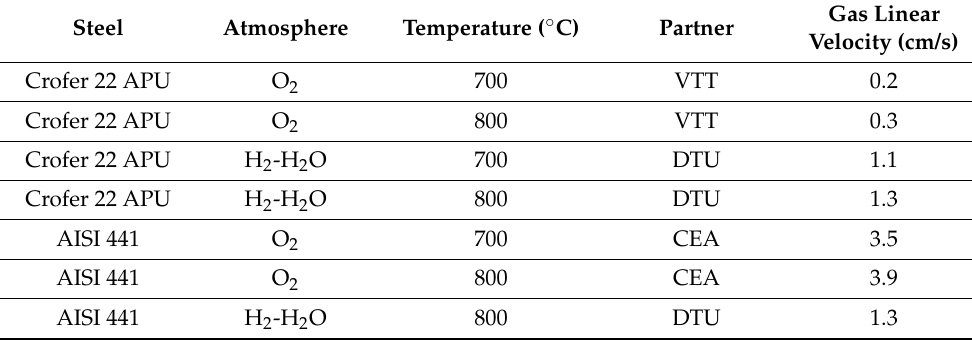
Table 3. Gas linear velocities used in the